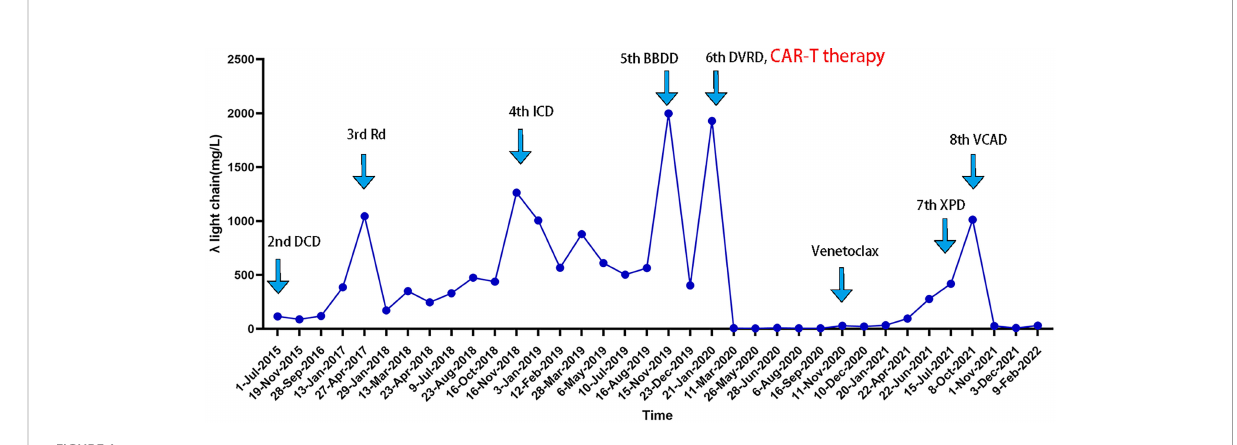
FIGURE 1 Free light chain concentration of the patient in different treatment